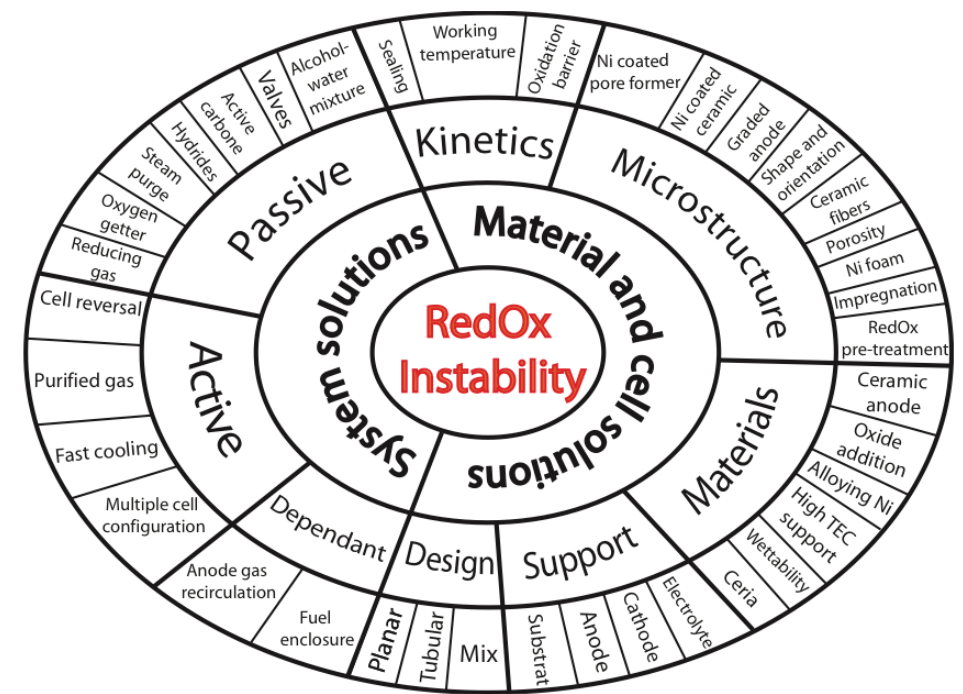
Figure 22. Summary of the solutions for anode RedOx instability